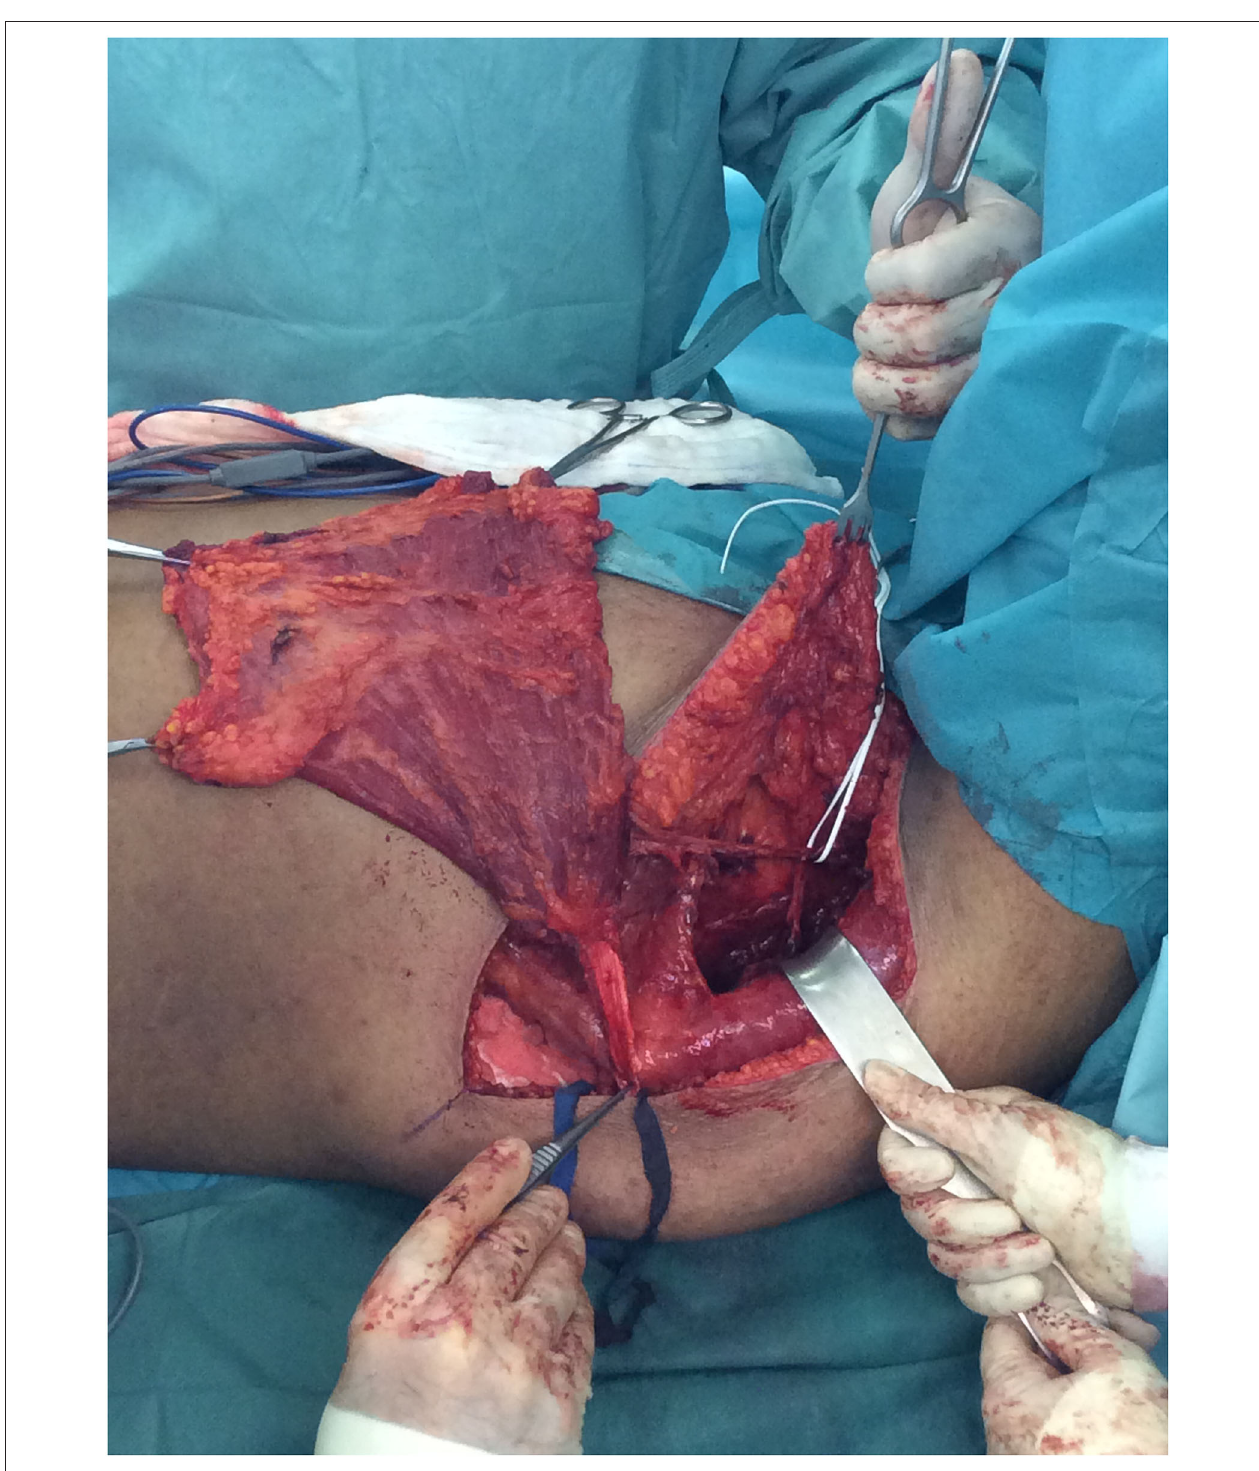
FIGURE 2 | Complete elevation of the LDM except for the neurovascular